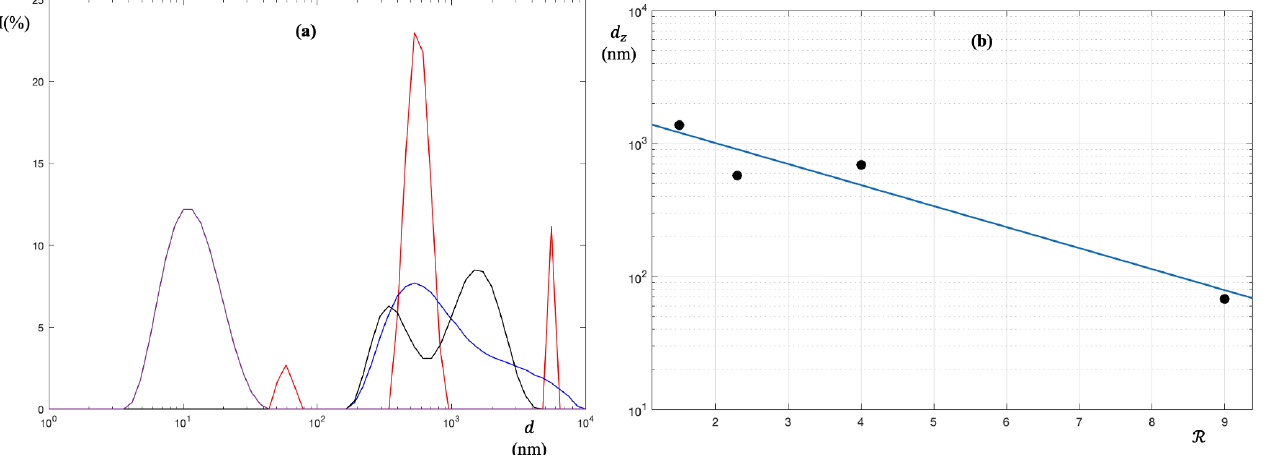
Figure 3. ( a ) Particle size distributions of mixed PLGA-EPK dispersions as measured by DLS. Purple curve R = 1.5, blue curve R = 2.3, black curve R = 4, and red curve R = 9. ( b ) Semi-log plot of Z-average as a function of the ratio R , linearity indicates that the d z decreases